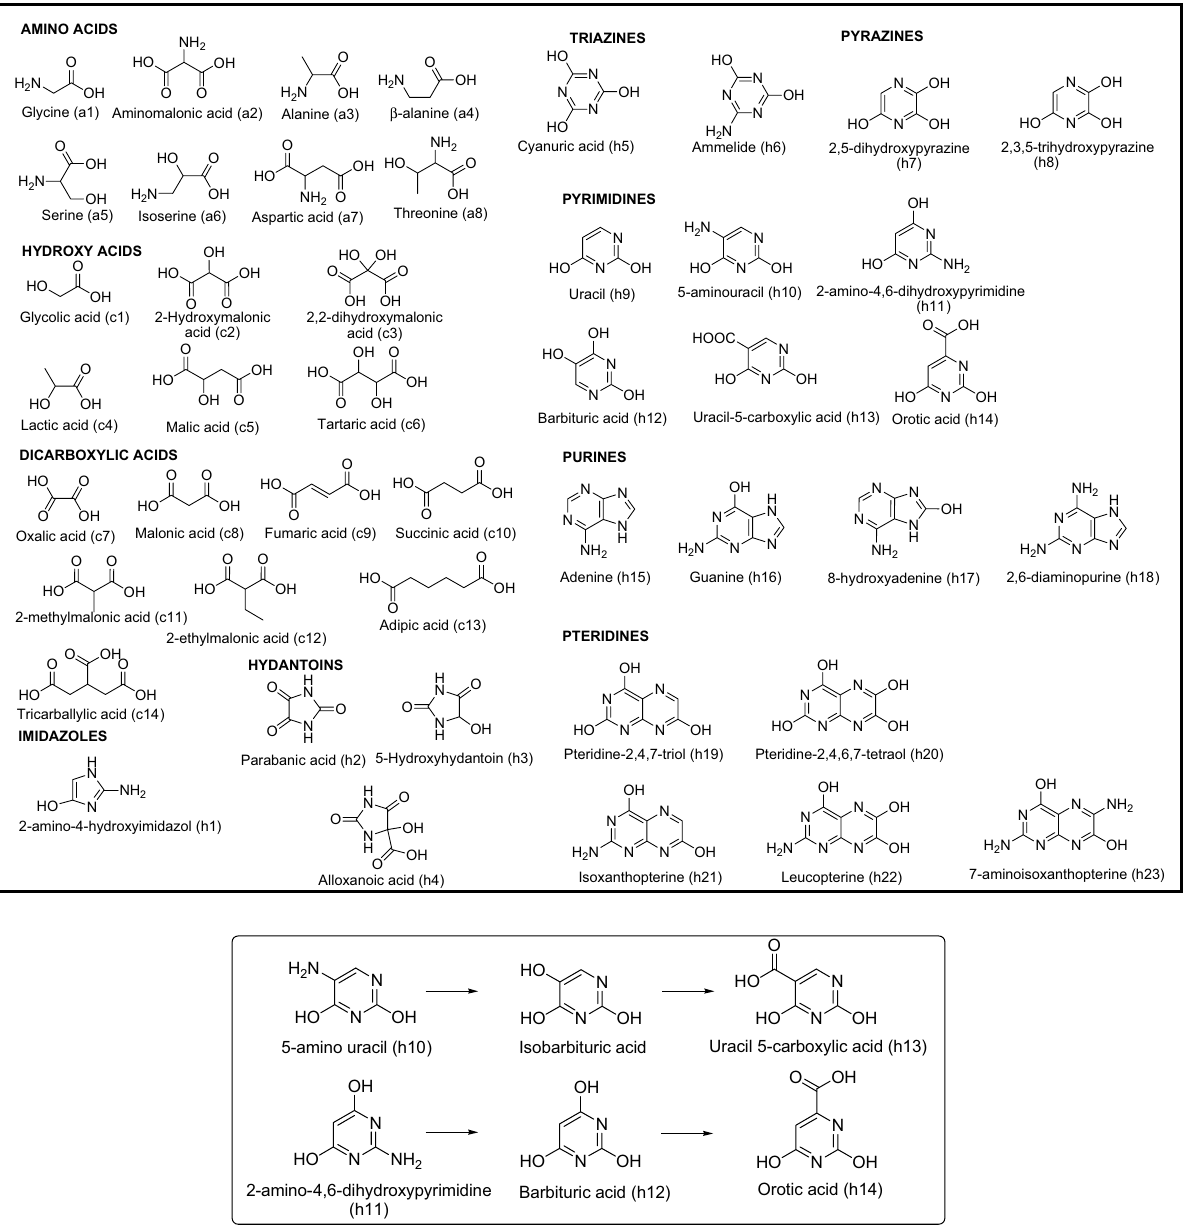
Figure 4. Upper square: All the polar organics identified by GC–MS from samples of NH 4 CN polymers synthetized under the microwave conditions present in this work. They are shown the tautomer form identified by GC–MS of each analyte as their TMS derivatives. Bottom square: Hypothetical oxidation reactions during the acid hydrolysis conditions